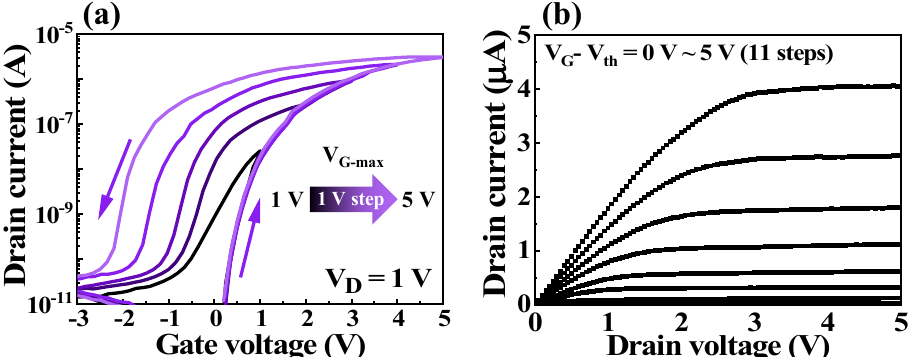
Figure 4. ( a ) Double-sweep transfer (I D − V G ) curves according to maximum V G (1 to 5 V, 1 V incre- ments). ( b ) Output curves (I D − V D ) according to V G − V th (0 to 5 V, 0.5 V increments). increments). ( b ) Output curves (I